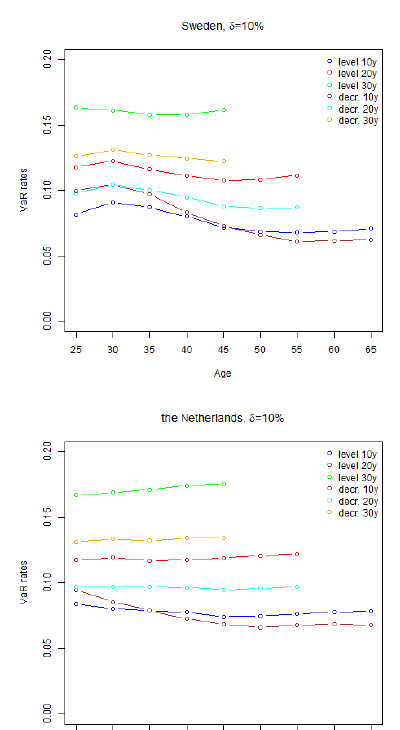
Figure 3. Calculated one-year VaR rates (parameter δ = 5%) at policy inception by country for different ages at policy inception, three different terms to maturity (10 years, 20 years and 30 years) and two benefit formulas (level sum assured and sum assured decreasing with time).